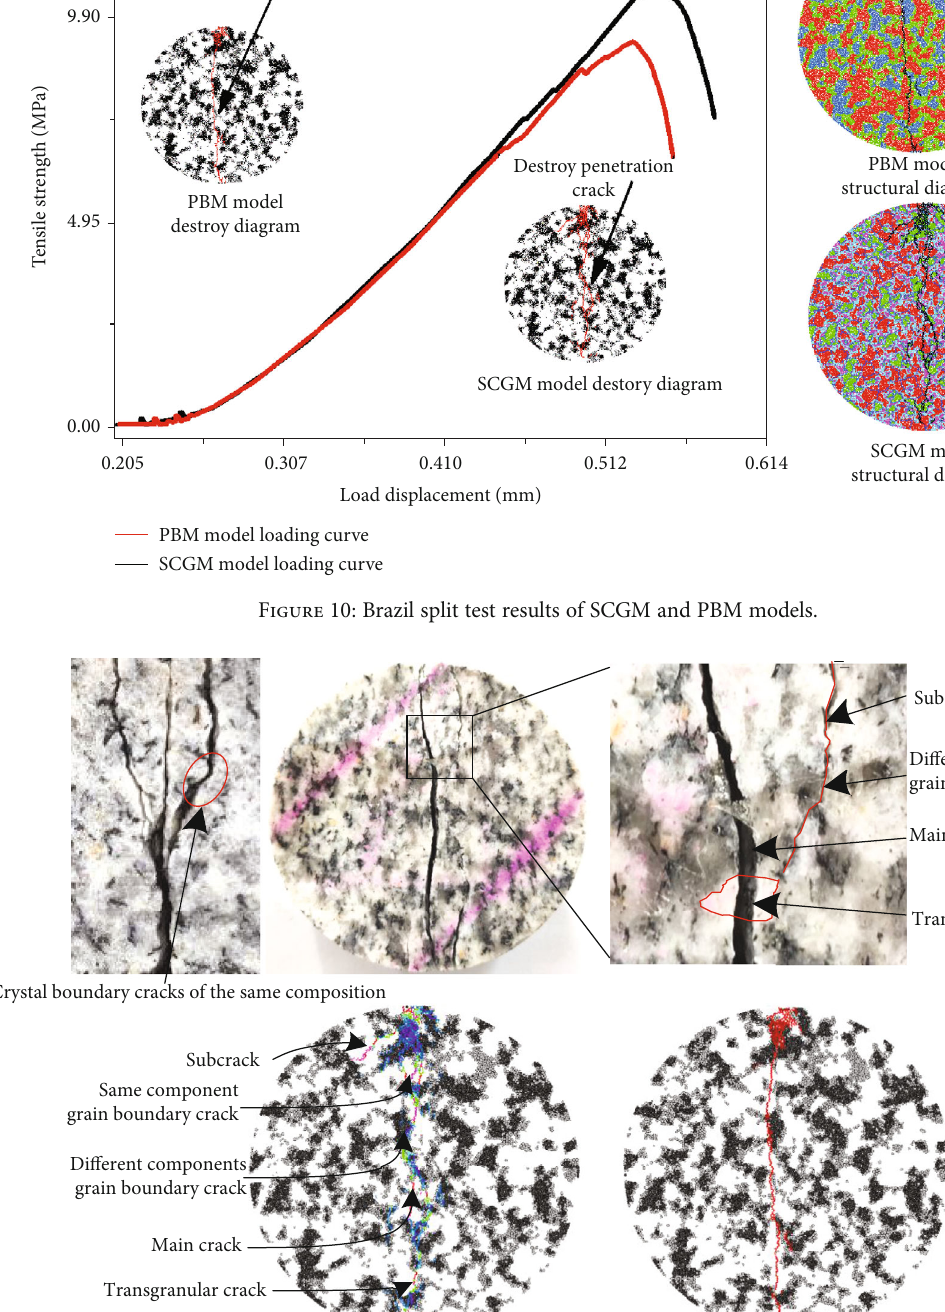
Figure 11: Modelling and actual splitting e ff ect of spatial correlation function structure